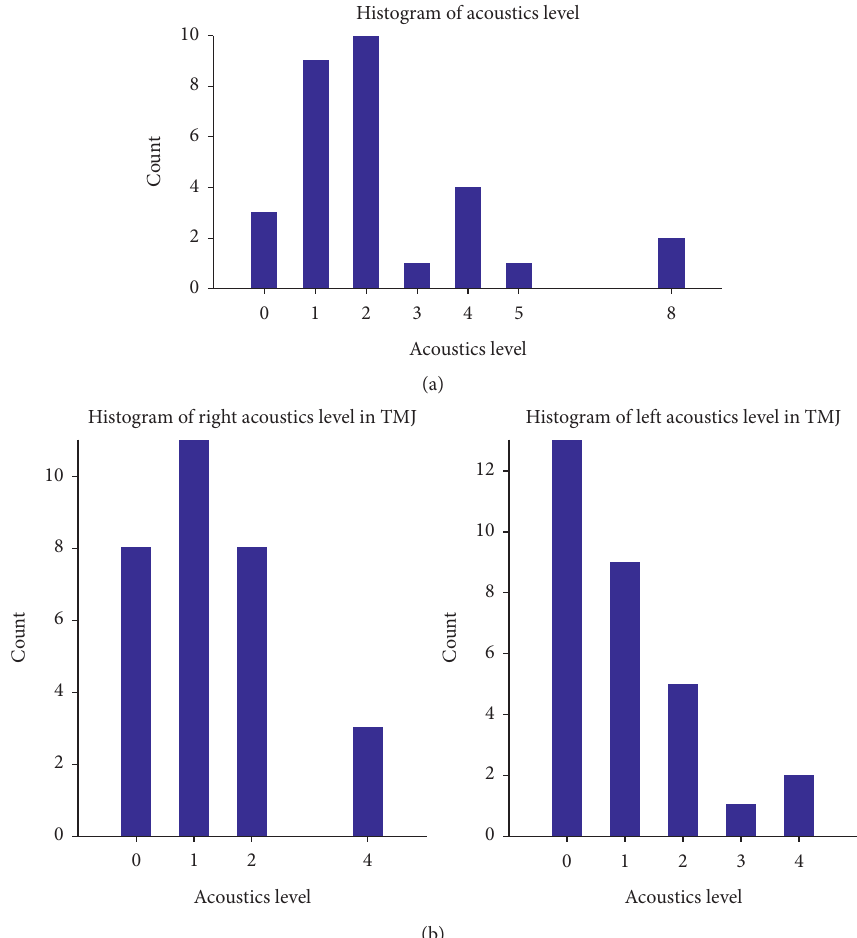
Figure 9: (a) Histogram of general acoustic abnormalities. (b) Histogram of acoustic abnormalities with division into the left and right TMJ.